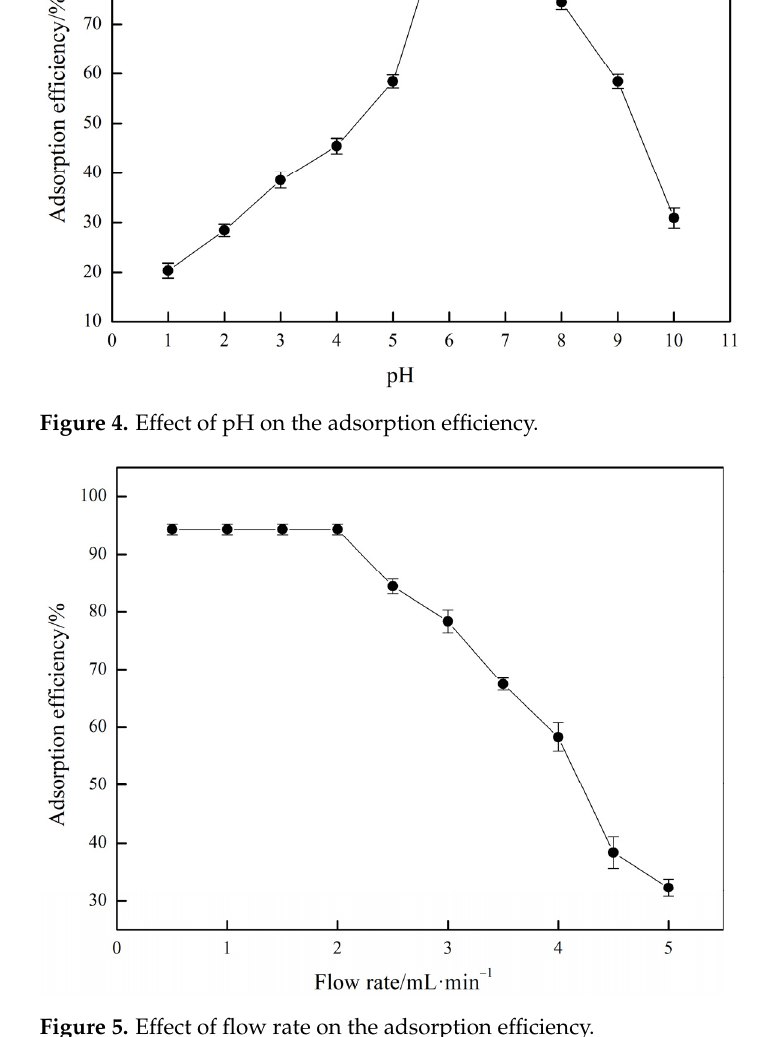
Figure 4. Effect of pH on the adsorption efficiency.